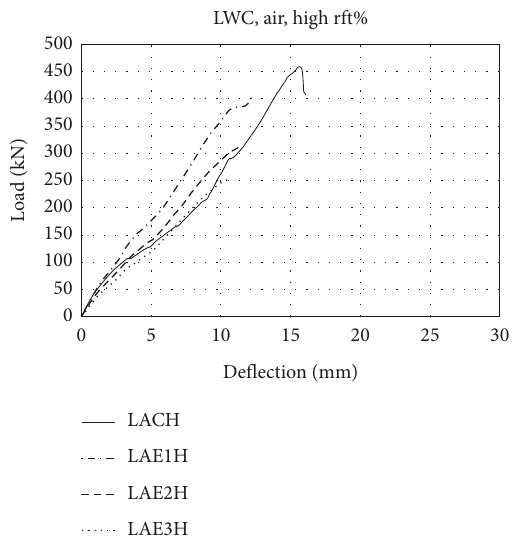
Figure 5: Effect of e / t ratio on the load-deflection curves for LWC with high RFT%.